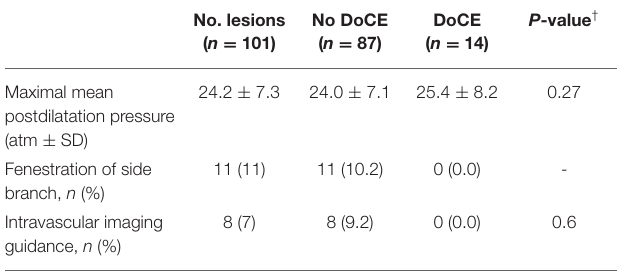
TABLE 2 | Lesion characteristics grouped according to outcomes during